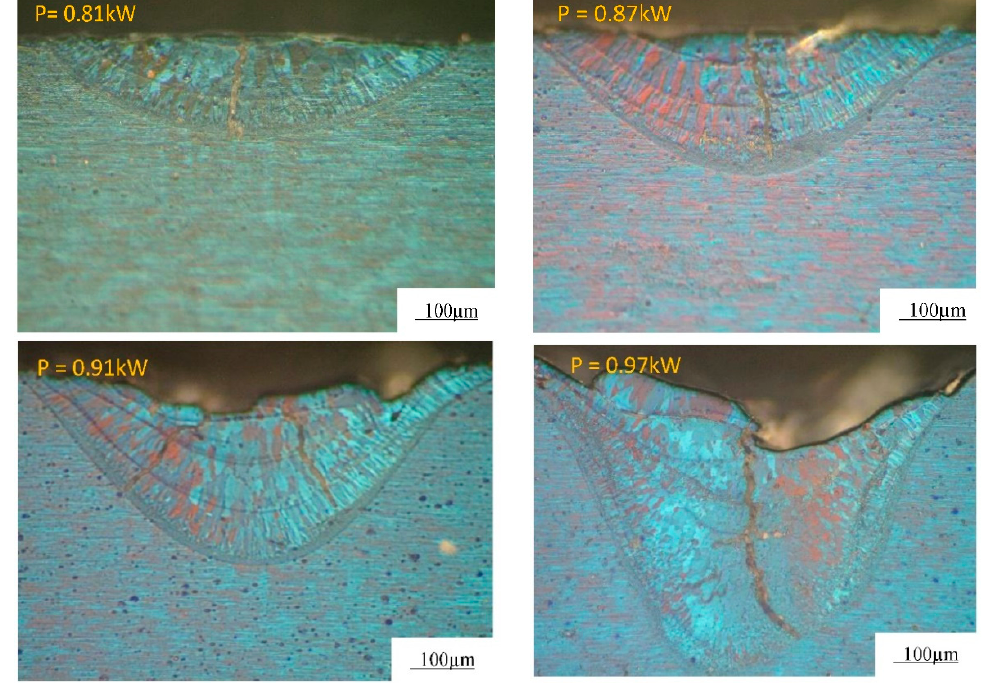
Figure 1. Influence of laser peak power on the cross-section shape of the weld seam. (V = 2 mm/s; Ar f = 15 mm − 1 ; Δ z = − 2 mm).